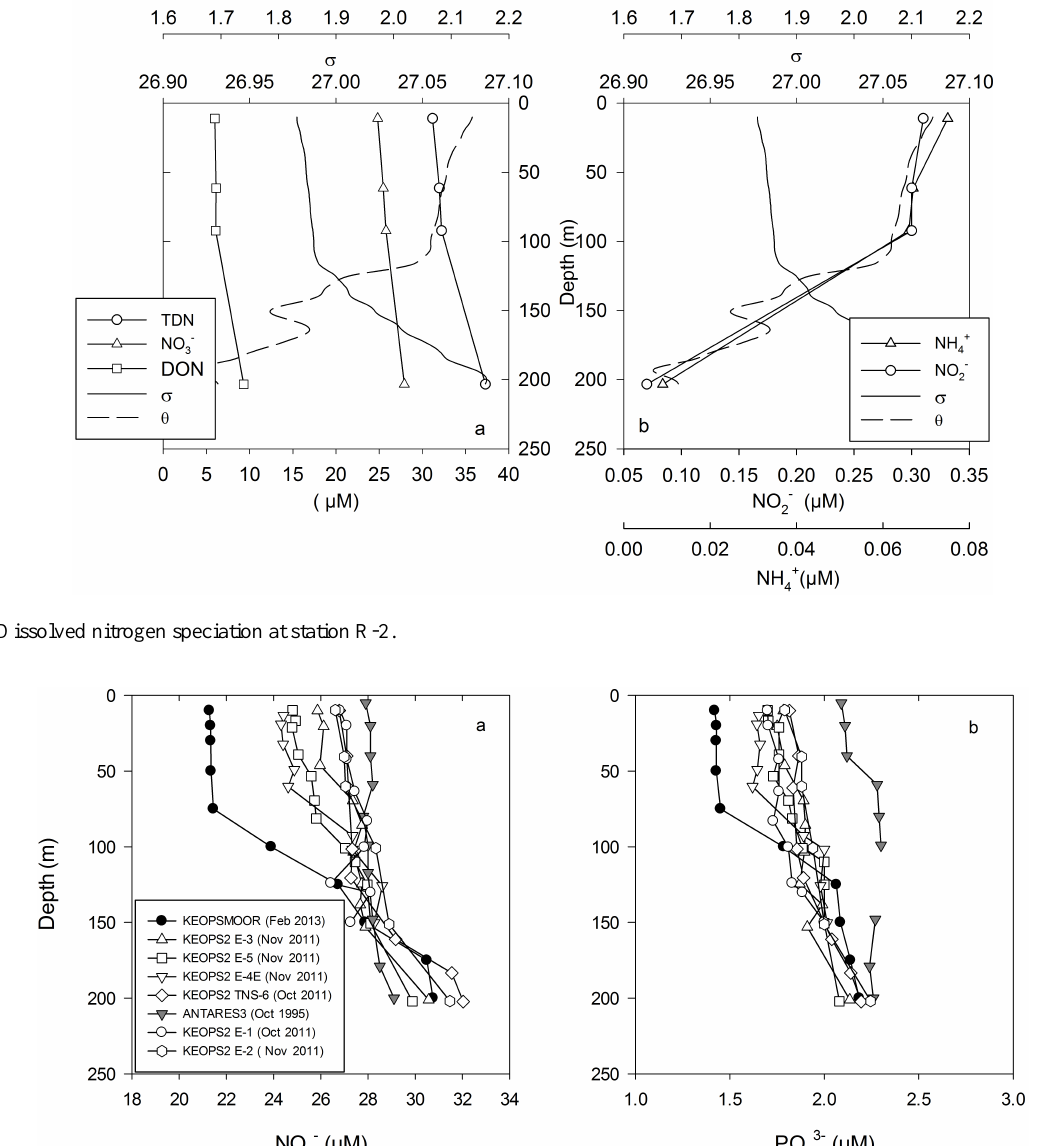
(a) and PO 3 − (b) for stations located in the meander of the 3 4